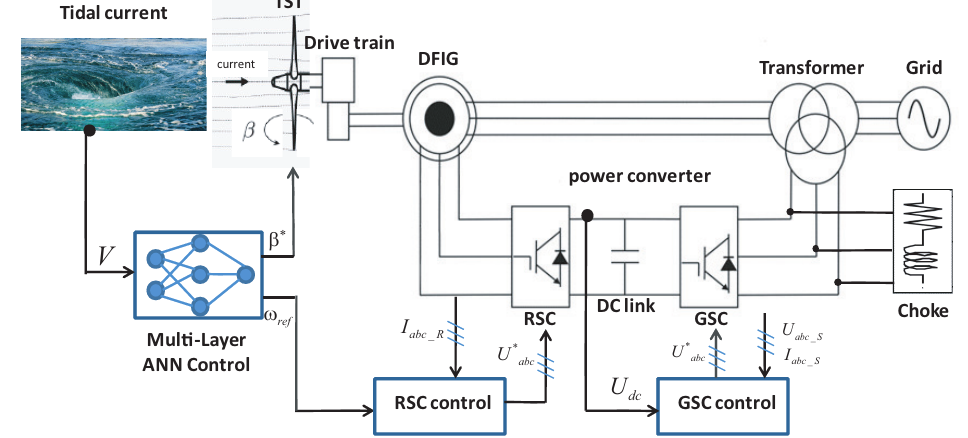
Figure 3. General scheme of a DFIG-based TST system and control